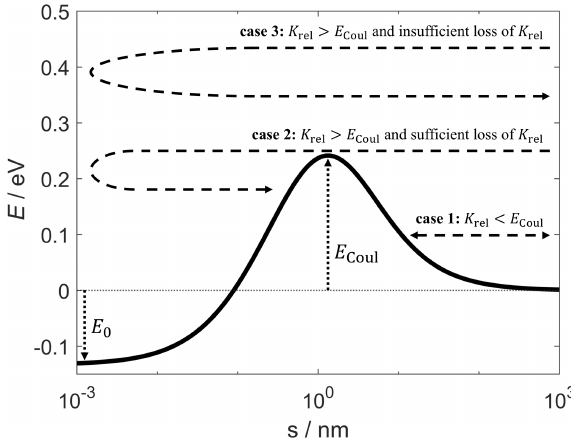
Figure 1. Possible outcomes for a collision between like-charged particles. The total energy is schematically split into two compo- nents, i.e. the electrostatic interaction energy (solid) and the relative kinetic energy (dashed). The electrostatic interaction energy profile is calculated for a collision between an ice particle ( r 1 = 3nm) and a SiO 2 particle ( r 2 = 0 . 5nm), with both particles carrying a charge of q 1 = q 2 = − 1 e